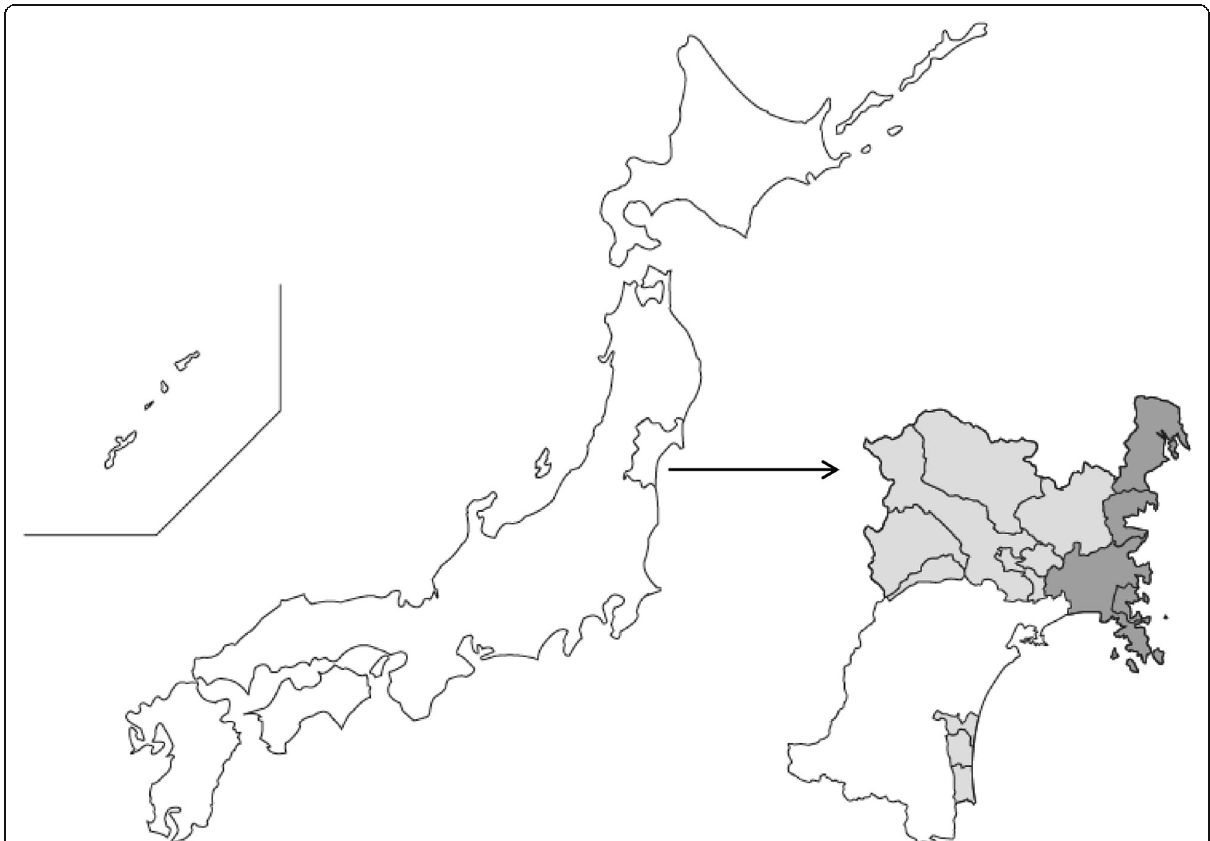
Fig. 1 Study area of JECS (light gray) and of the adjunct study (dark gray) in Miyagi